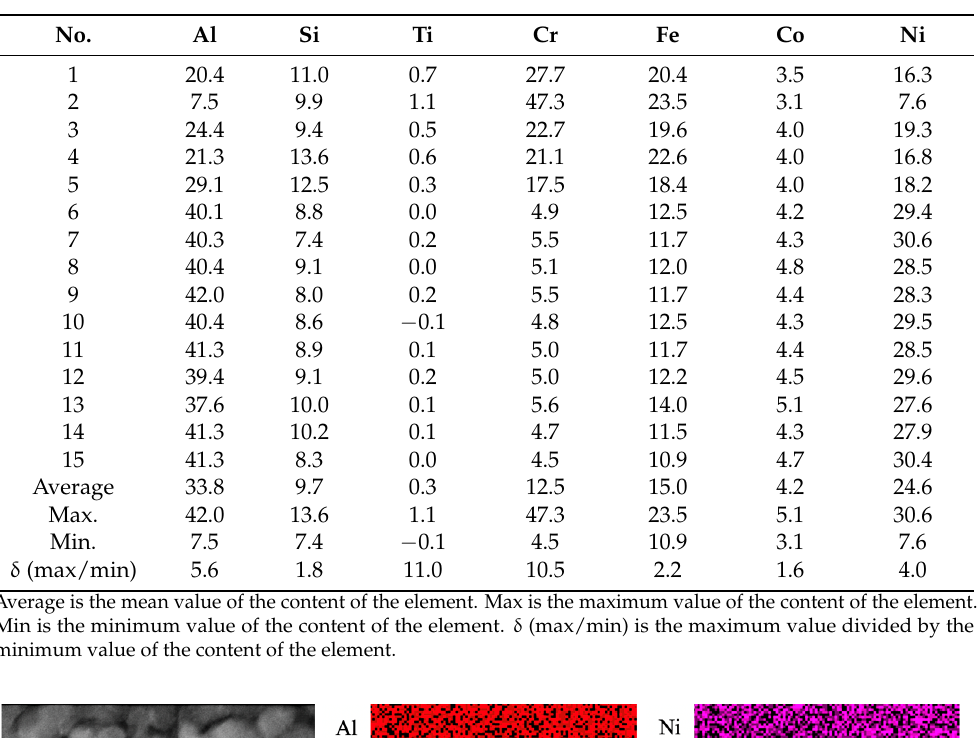
Table 4. The TEM-EDS elemental mapping outcomes (at. %) of the foil section presented in Figure 11. No.